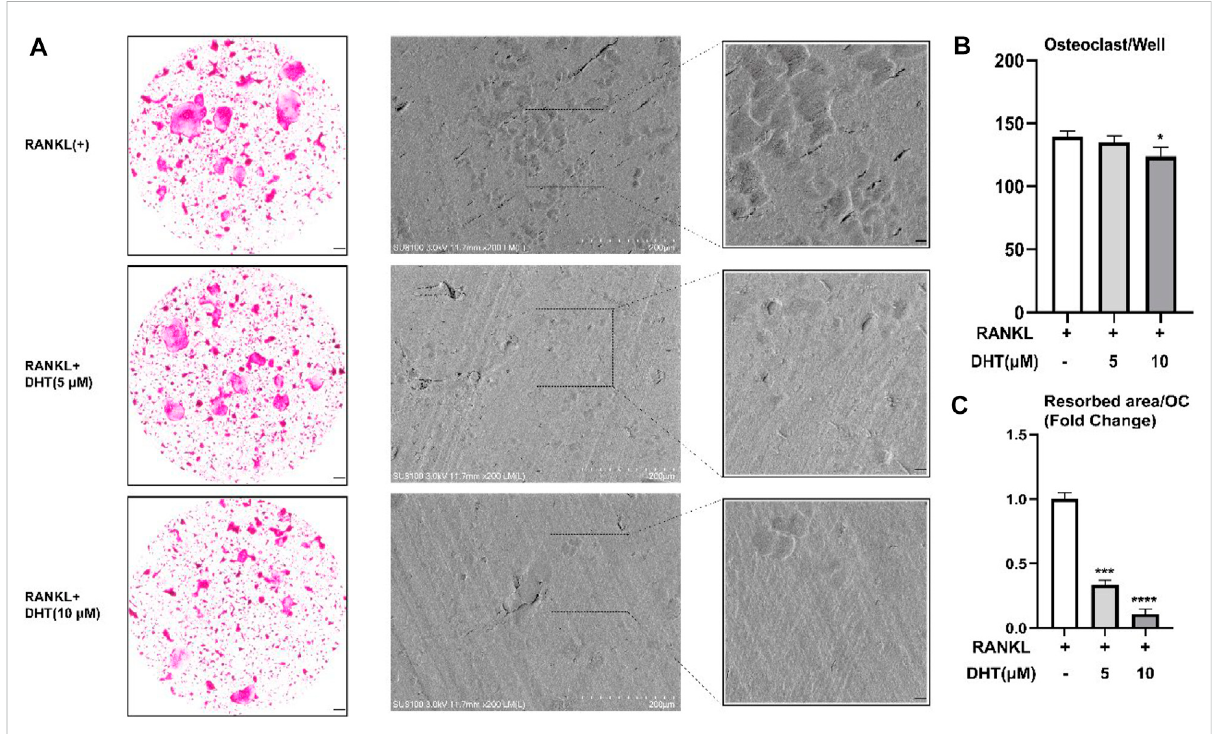
FIGURE 6 Effect ofDHTon bone resorption of osteoclasts. (A) DHT interfered with mature osteoclasts for 48 hand found astatistical difference at10 μ M concentrations. (B,C) There was a signi fi cant difference between the number of osteoclasts and the area of bone resorption. * p < 0.05, *** p < 0.001, **** p < 0.0001 relative to the RANKL-induced control group. Scale Bar = 200 μ